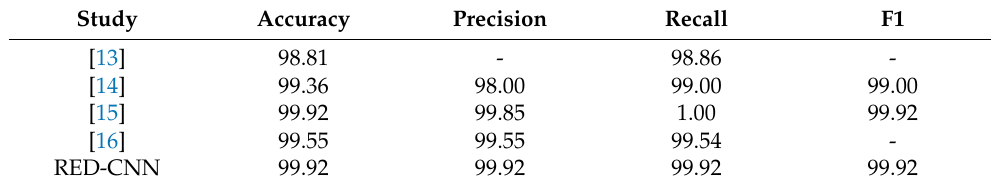
Table 6. Comparison of RED-CNN with other studies based on curated COVID-19 dataset.